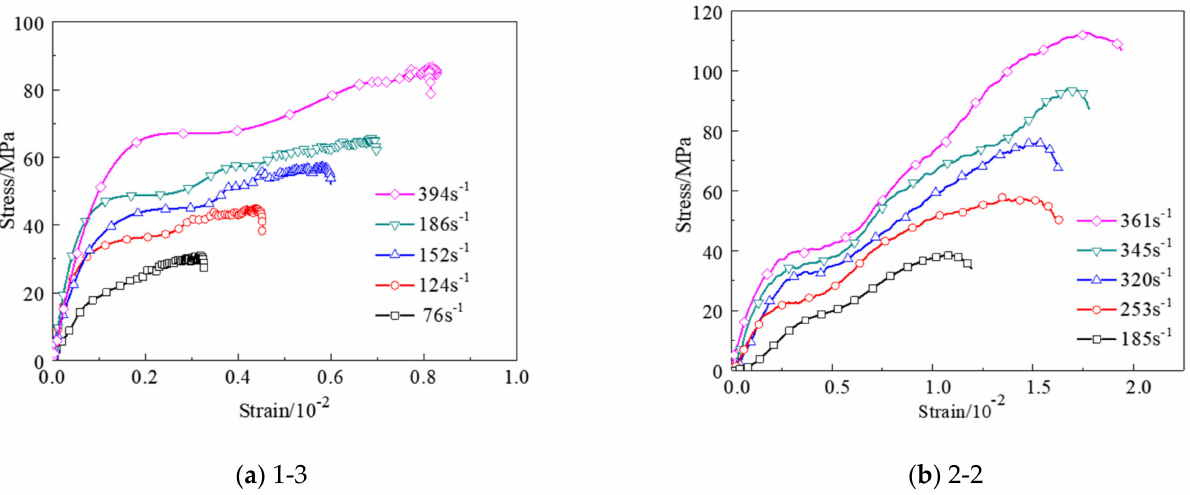
Figure 6. Stress-strain curves of the sample under different strain